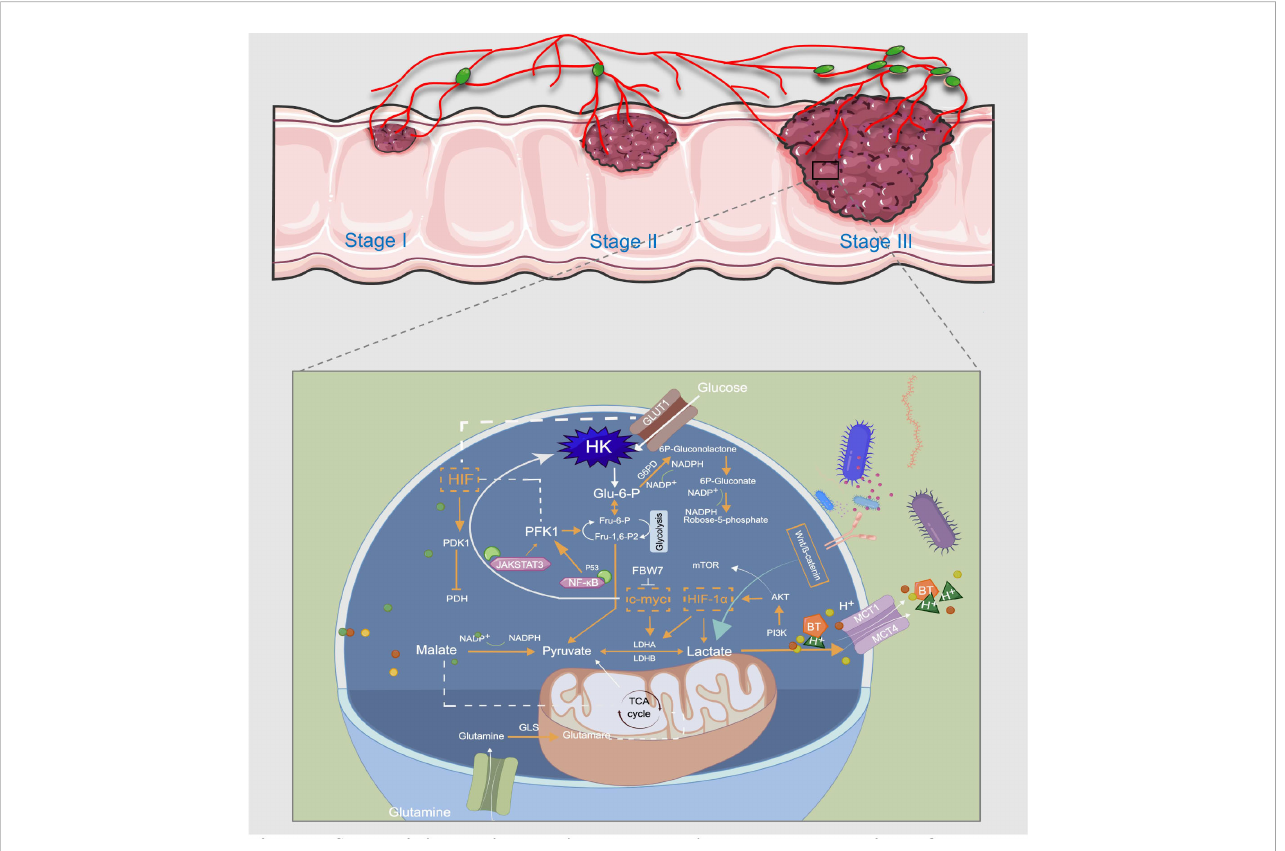
FIGURE 3 Schematic illustration showing the metabolic regulatory mechanisms of lactate involved in CRC treatment. Usually, the last step in glucose metabolism in cancer cells is aerobic glycolysis, which ef fi ciently breaks down the produced lactic acid. GLUT1 transports glucose from the extracellular microenvironment into the cell and generates pyruvate through a series of reactions. This is the fi rst stage of glycolysis, and a variety of enzymes, such as HK and PFK, are the rate-limiting enzymes in this stage. LDHA and LDHB can mediate the bidirectional conversion of pyruvate and lactate, and sustained activation of HIF-1a, c-Myc, and mTOR pathways induce abnormal expression of multiple glycolytic enzymes, thereby promoting aerobic glycolysis of cancer cells. MCT-1 can mediate BT transport, and acetate promotes lactate production through the plasma membrane relocalization of MCT-1. Glutamine and pyruvate participate in the TCA cycle in mitochondria for oxidative energy supply. Lactate controls CRC metabolic reprogramming in multiple steps to meet the metabolic energy demands of cancer cell proliferation and metastasis. This image was drawn by